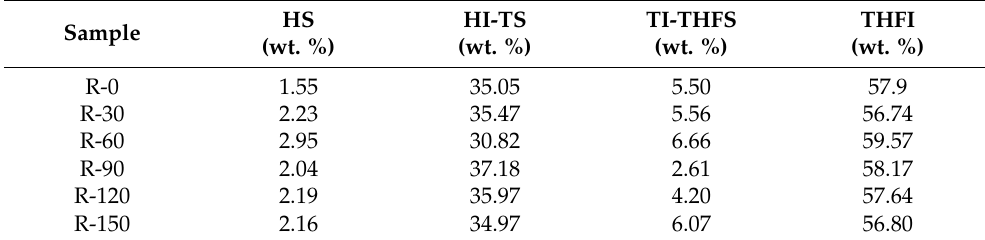
Table 1. Extraction yield of spinnable pitch after different incubation days.